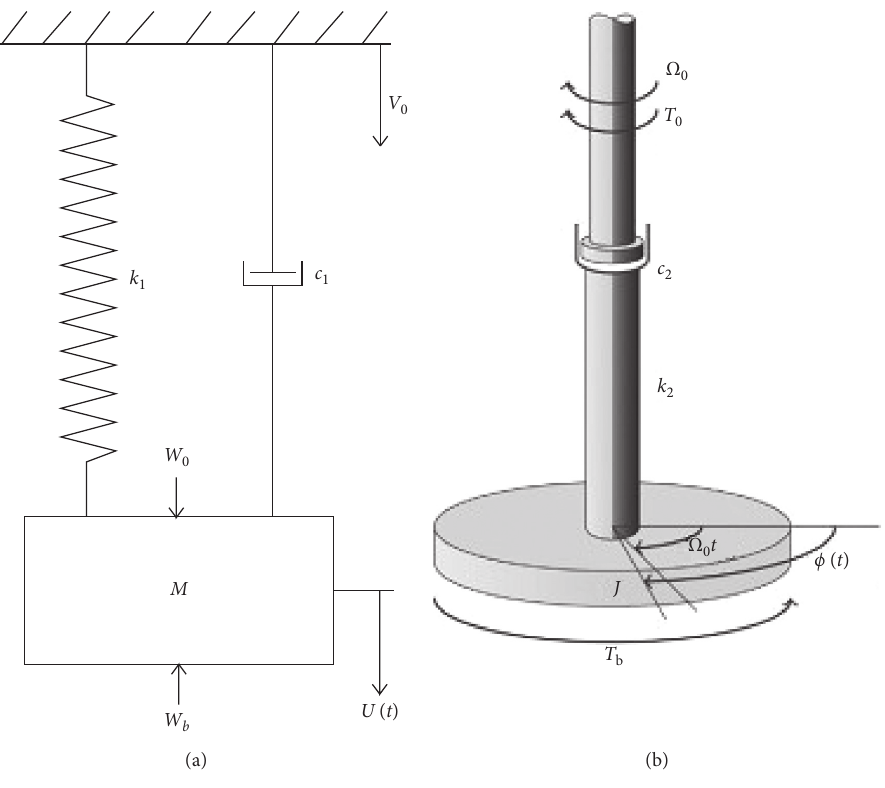
Figure 1: Physical model of drill string: (a) axial vibration; (b) torsional vibration.